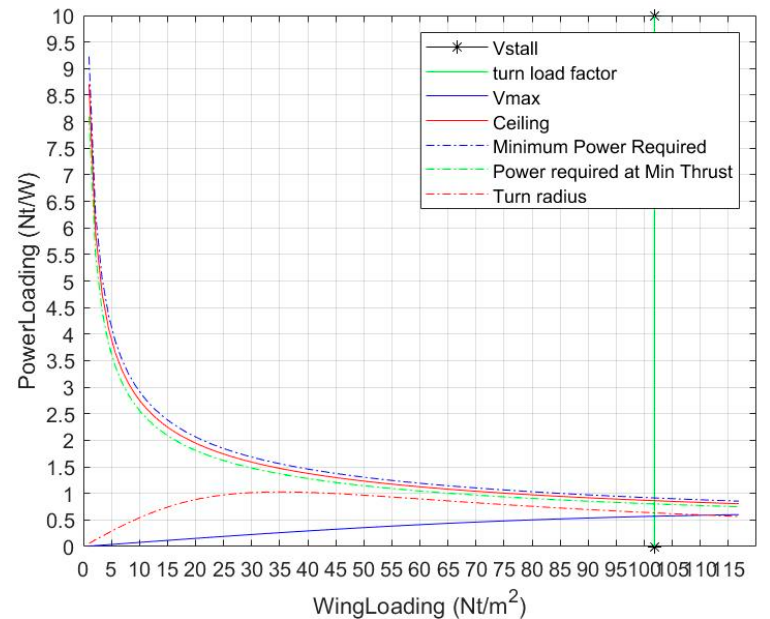
Figure 19. Matching plot for actual experimental flying wing UAV.